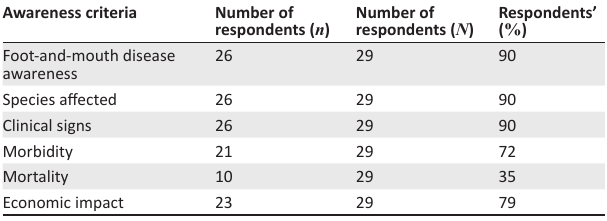
TABLE 3: Farmers’ awareness about foot-and-mouth disease and its economic impacts.